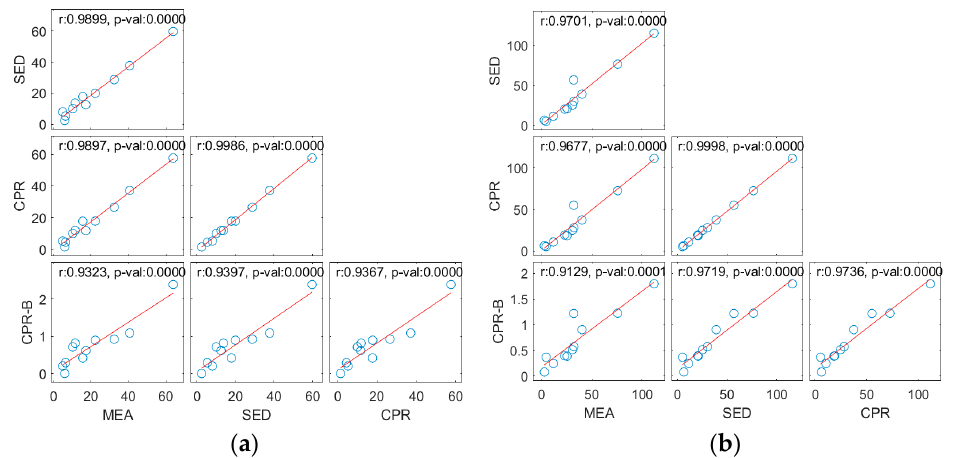
Figure 11. Correlation matrix among three approaches (SED, CPR, and MEA) plus CPR-B, which is a slope parameter ( b 1 or b 2 ) based on Total energy consumption (Table 3): ( a ) cooling-related energy use; ( b ) heating-related energy use.